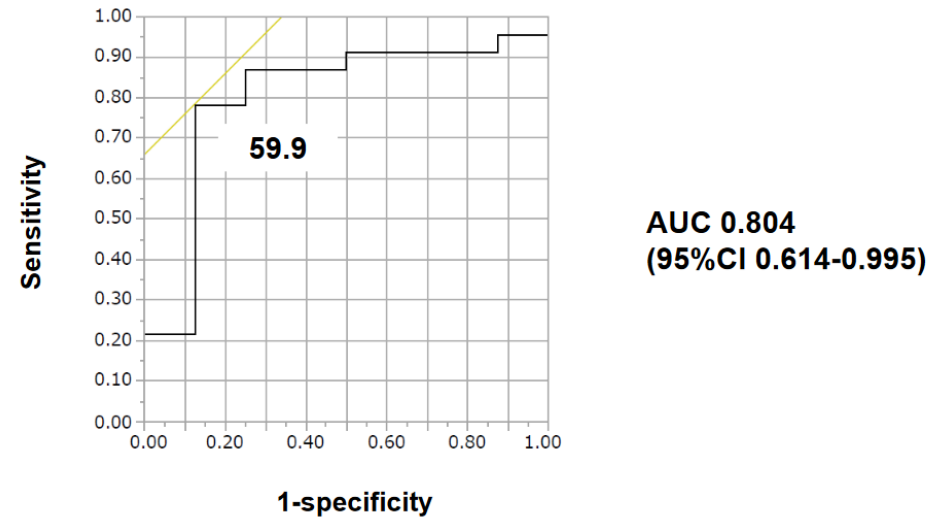
Figure 3. The cut-off of vWF large-multimer index for 30-day survival was calculated as 59.9 with an area under the curve of 0.80435 by receiver operating characteristics analyses. AUC—area under the curve; CI—confidence interval The unadjusted odds ratio of vWF large-multimer index <59.9% for the primary end- point was 0.044 (95% confidence interval 0.004-0.403, p = 0.0008), and the adjusted odds